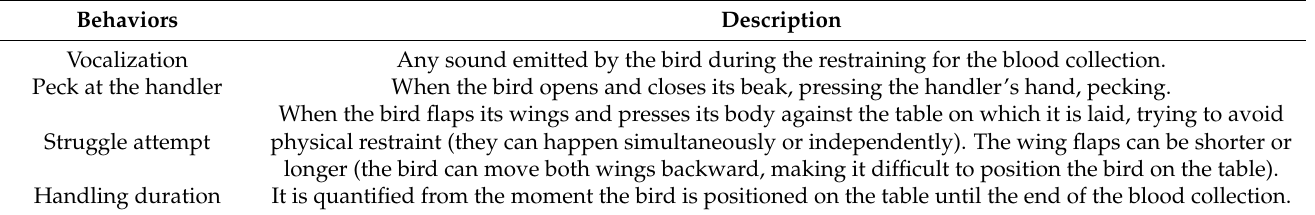
Table 1. Behavioral categories (response variables) recorded during the manual restraint test. Behaviors